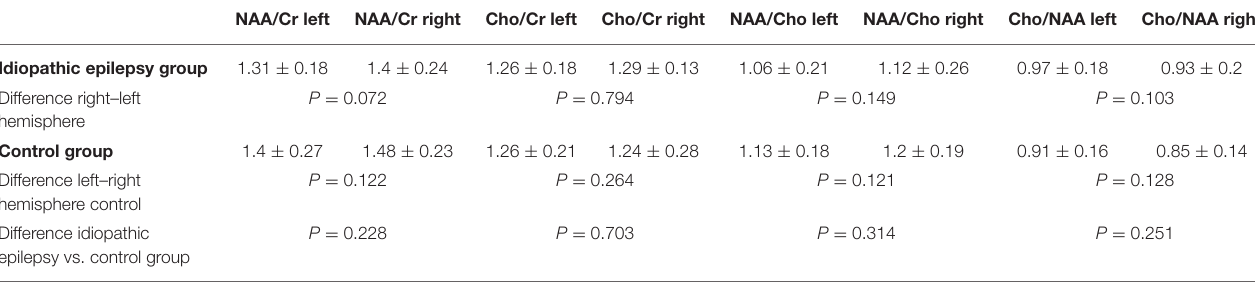
TABLE 3 | Mean, standard deviation, and P -values for calculated brain metabolite ratios [N-acetylaspartate (NAA)/creatine (Cr), choline (Cho)/Cr, NAA/Cho, Cho/NAA] of dogs included in the idiopathic epilepsy and control groups.